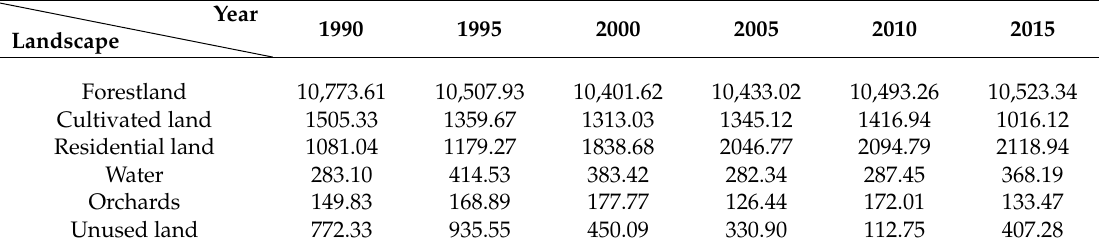
Table 12. The area of landscape change in the Jiulong River basin (km 2 ).